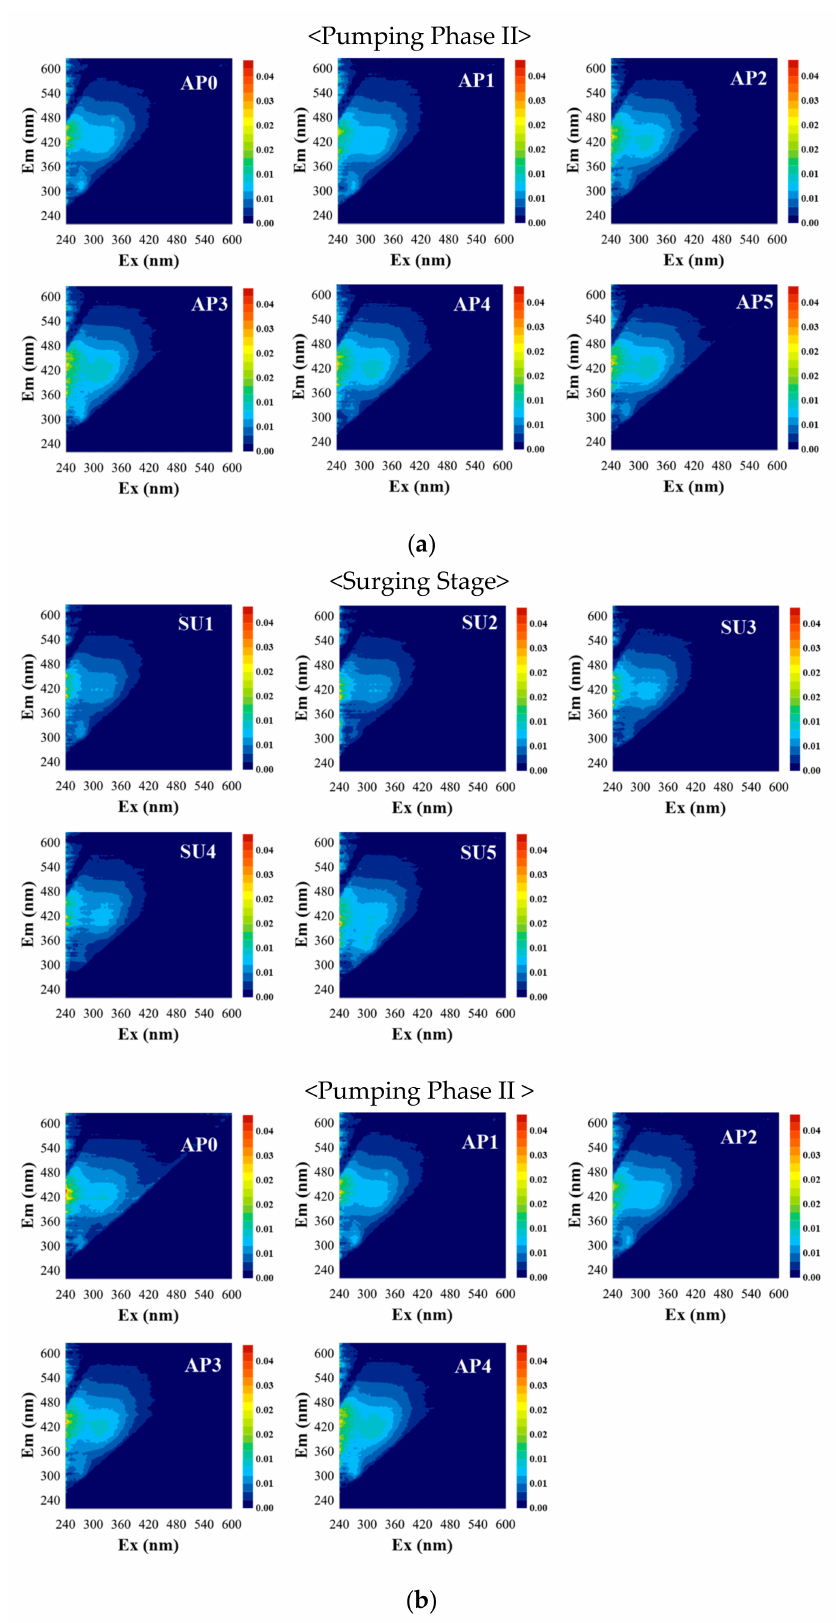
Figure 7. Variation in fluorescence EEM off dissolved organic matter (DOM) of groundwater during pumping tests performed before and after well surging in the ( a ) D-8 and ( b ) D-7